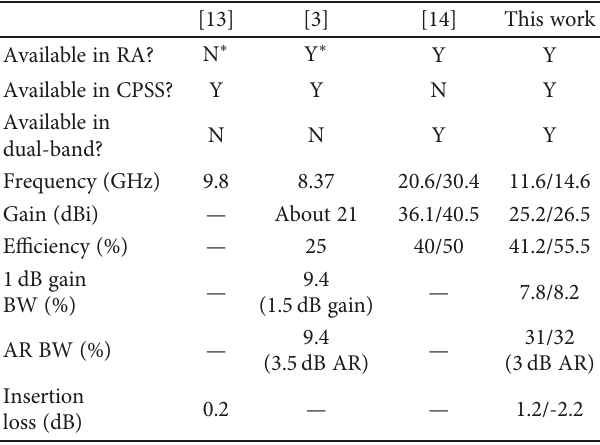
Figure 11: Measured transmission coe ffi cients of the re fl ectarray versus frequency under RHCP and LHCP illuminations. Table 1: Comparison with existing relevant